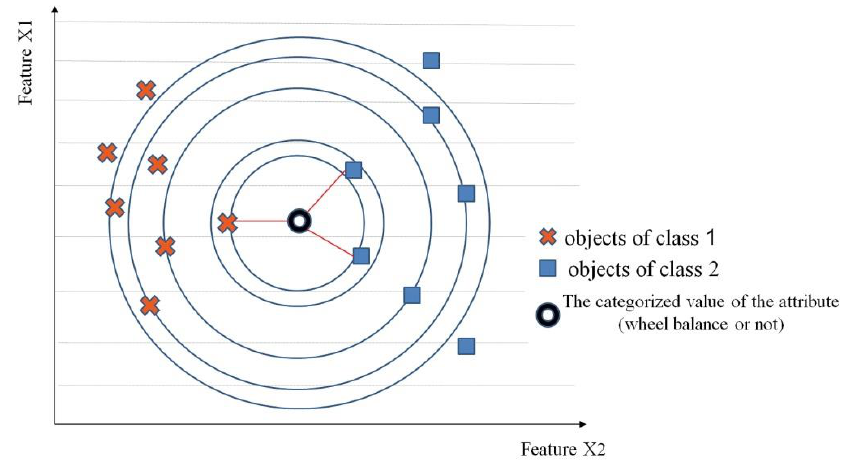
Figure 17. Application of multi-category object classification for sample classes.